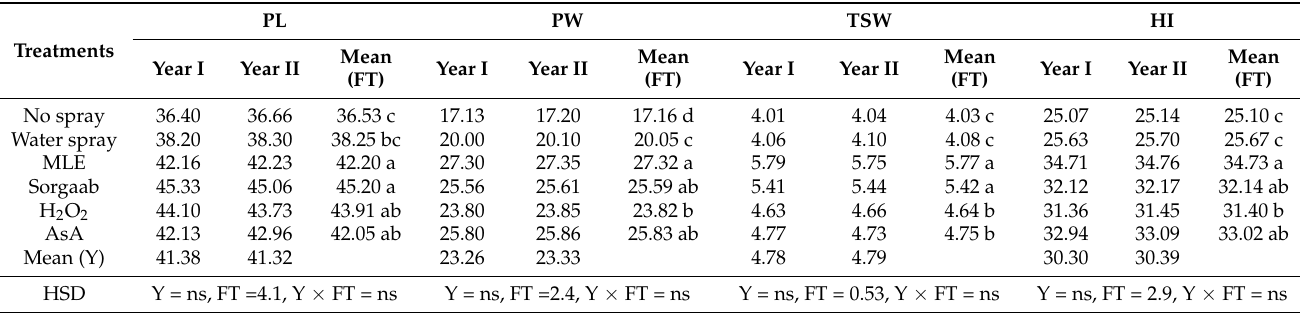
Table 4. Impact of foliar applied plant growth enhancers on grain quality of quinoa cultivated during the growing seasons of 2016–2017 (Year I) and 2017–2018 (Year II).